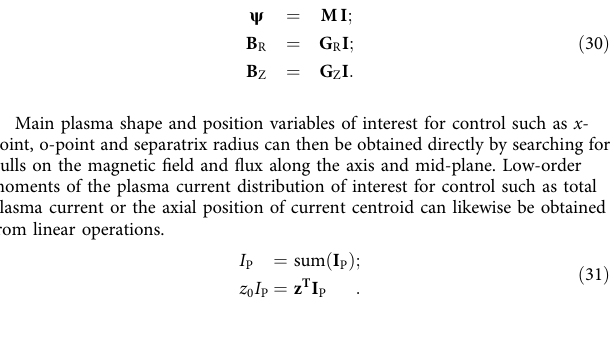
Fig. 8 C-2U magnetostatic model. Toroidal plasma current is modelled using 734 discrete plasma current elements modelled as block coils (back grid inside the vessel contour in blue). The vessel is modelled using 31 fl at block coil elements (not shown). Insulating quartz tubes (formation sections) are shown in red. All the magnets in con fi nement and formation sections are considered. Pulsed powered fast switching coils for plasma formation and acceleration (not shown) are located right outside the quartz tube. Magnetic probes inside and outside the con fi nement vessel are shown as red